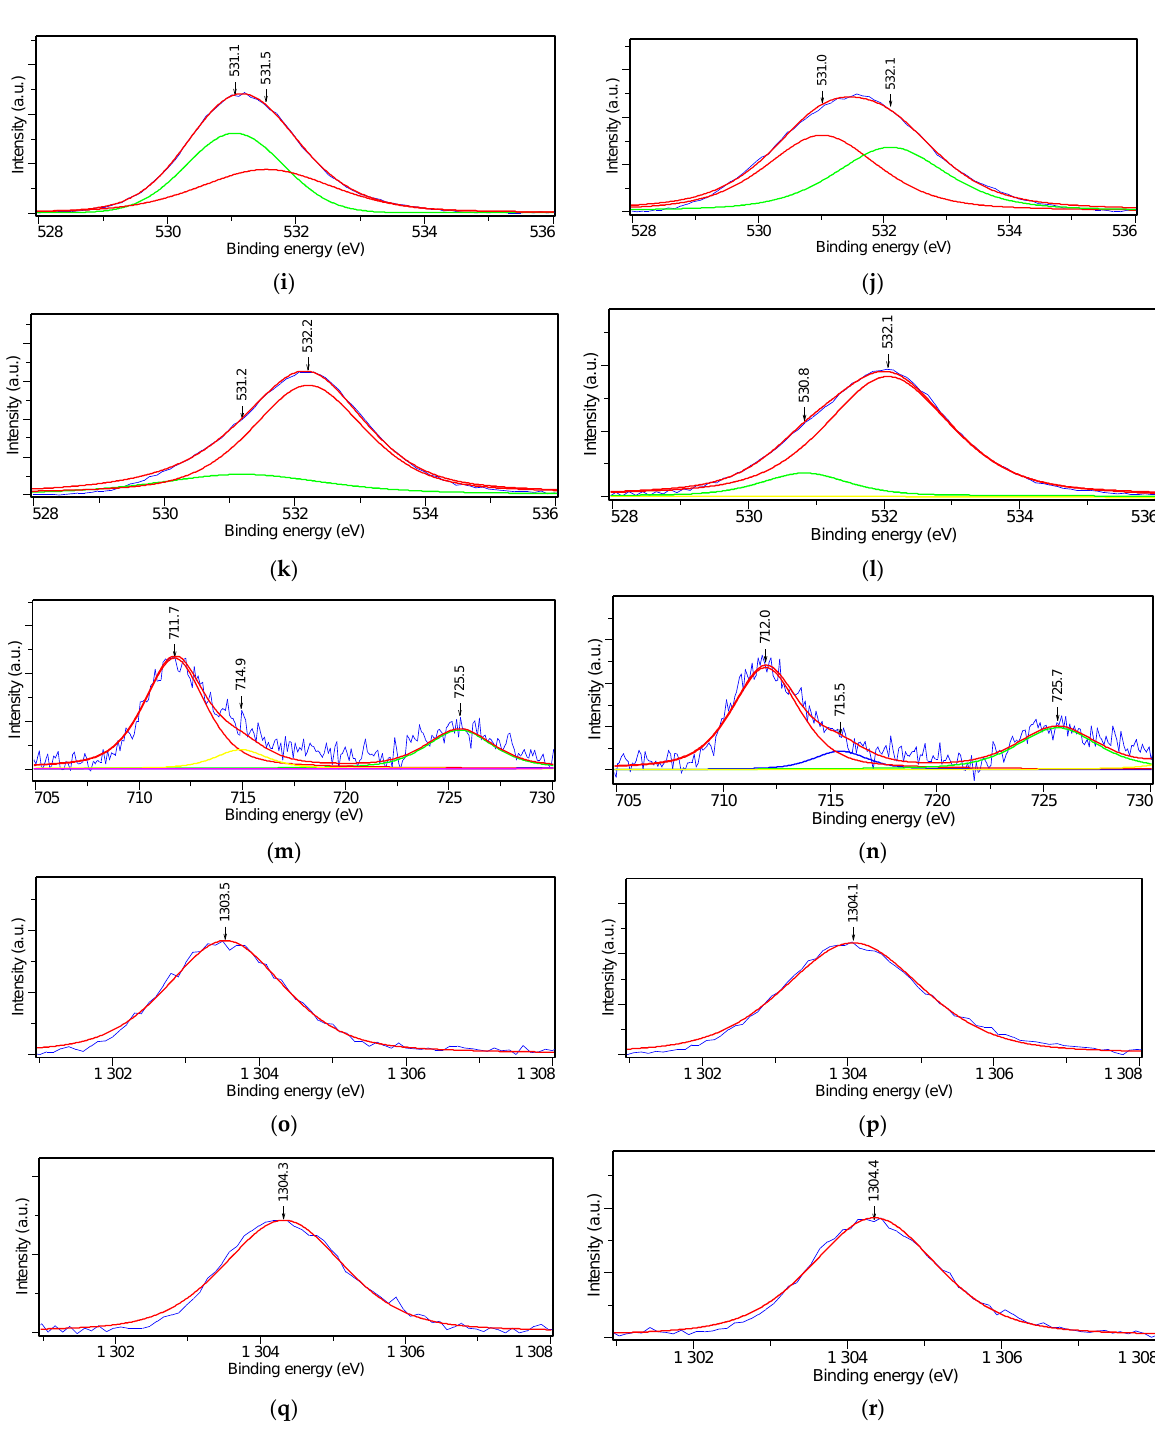
Figure 8. XPS high-resolution spectra of powders: natural sepiolite ( a ), S1 ( b ), S1FeSUB ( c ) and S1FeXS ( d ) (Mg 2p lines); natural sepiolite ( e ), S1 ( f ), S1FeSUB ( g ) and S1FeXS ( h ) (Si 2p lines); natural sepiolite ( i ), S1 ( j ), S1FeSUB ( k ) and S1FeXS ( l ) (O 1s lines); S1FeSUB ( m ) and S1FeXS ( n ) (Fe 2p lines); natural sepiolite ( o ), S1 ( p ), S1FeSUB ( q ) and S1FeXS ( r ) (Mg 1s lines) (the blue line is the experimental curve, while the different colored lines are due to the deconvolution of the different peaks; the top red line is the sum of the overall deconvoluted